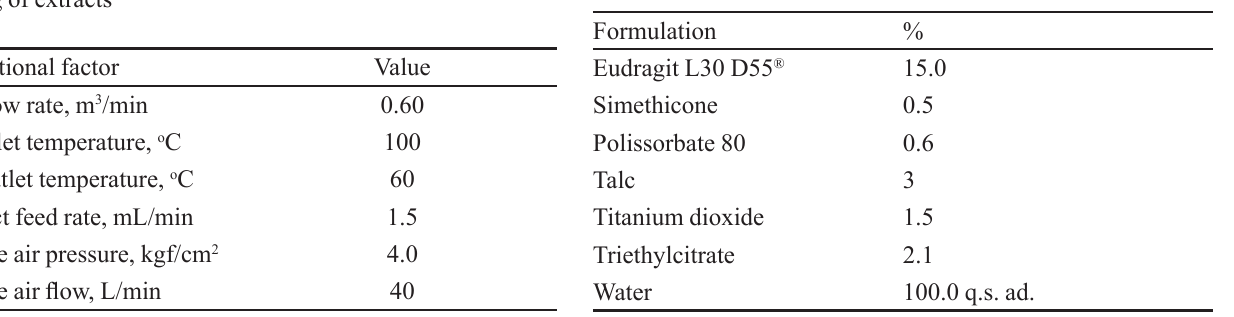
TABLE III - Composition of coating suspension for the feverfew